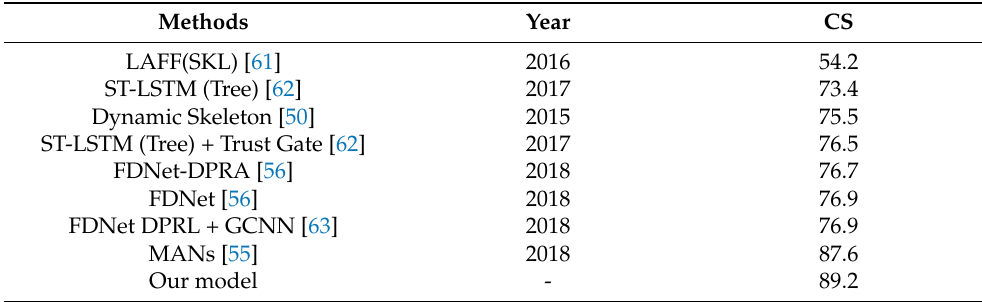
Table 4. Accuracy (%) achieved with previous models for cross-subject (CS) evaluation using SYSU dataset.